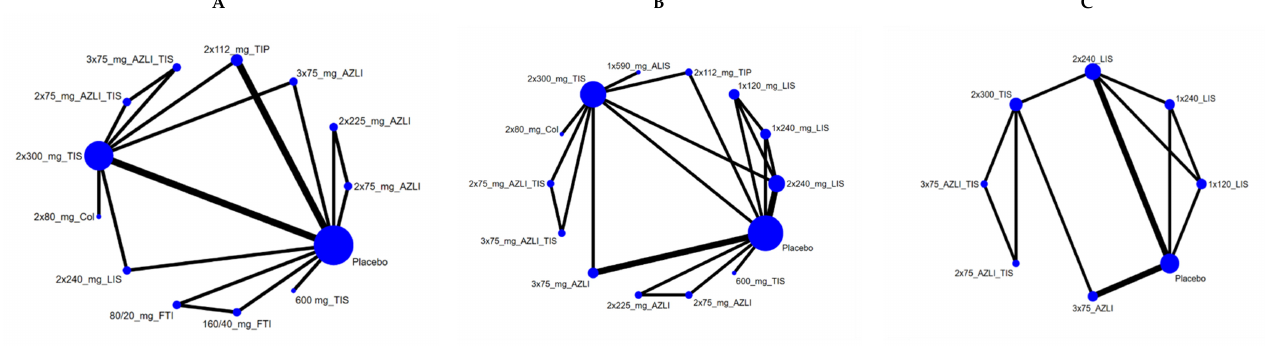
Figure 1. ( A ). Network graph of mean change in forced expiratory volume in 1 s per cent from baseline to four weeks. The widths of the lines are proportional to the number of studies, and the size of each circle is proportional to the sample size. TIS = tobramycin inhalation solution, AZLI = aztreonam lysine, FTI = fosfomycin/tobramycin, Col = colistin, LIS = levofloxacin. ( B ) . Network graph of mean change in Pseudomonas sputum density from baseline to four weeks. TIS = tobramycin inhalation solution, AZLI = aztreonam lysine, TIP = tobramycin inhalation powder, Col = colistin, LIS = levofloxacin, ALIS = amikacin inhalation solution. ( C ). Network graph of change in CFQR-RSS, TIS = tobramycin inhalation solution, AZLI = aztreonam lysine, LIS = levofloxacin.